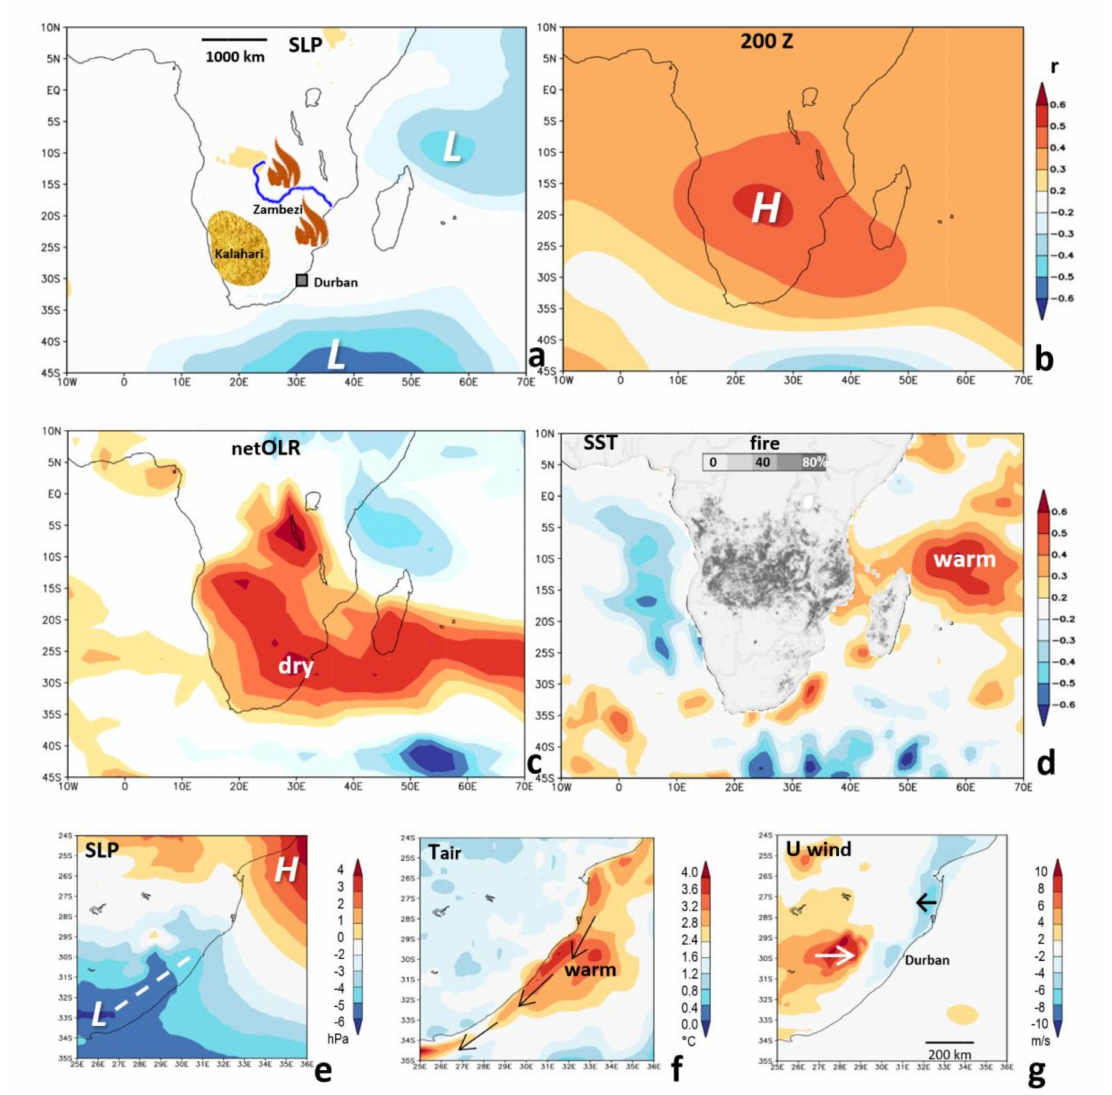
Figure 3. Point-to-field correlations (2001–2020) with respect to May–August monthly API for: ( a ) ERA5 sea level air pressure (SLP) with lows and place names, ( b ) ERA5 200 hPa geopotential height with high, ( c ) satellite net outgoing longwave radiation (OLR) and ( d ) sea surface temp (SST). Point-to-field regressions (N = 20) with May–August API for local: ( e ) SLP with icons, ( f ) surface air temperature, and ( g ) surface zonal wind with vectors; illustrating winter patterns associated with high air pollution over Durban; upper panels use the correlation scale at right; lower row has individual scales. Zambezi and Kalahari shown in ( a ); satellite July–September mean fire density grey-shaded in ( d ); dashed line in ( e ) refers to coastal trough; vectors in ( f ) highlight the Agulhas